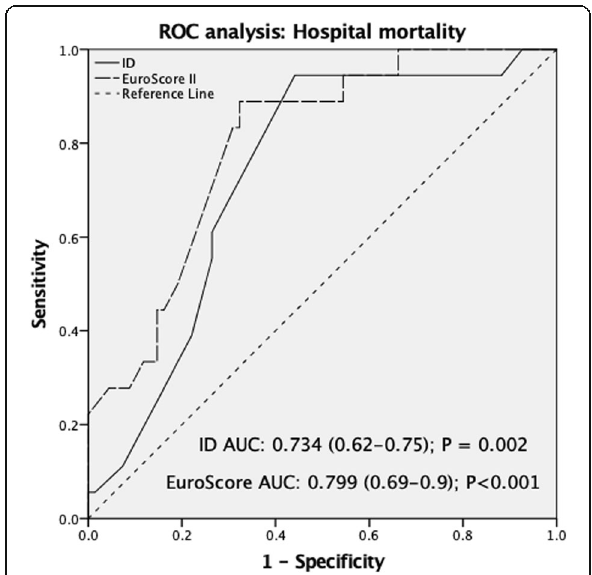
Fig. 3 ROC analysis: hospital mortality: index of deterioration versus EuroScore II